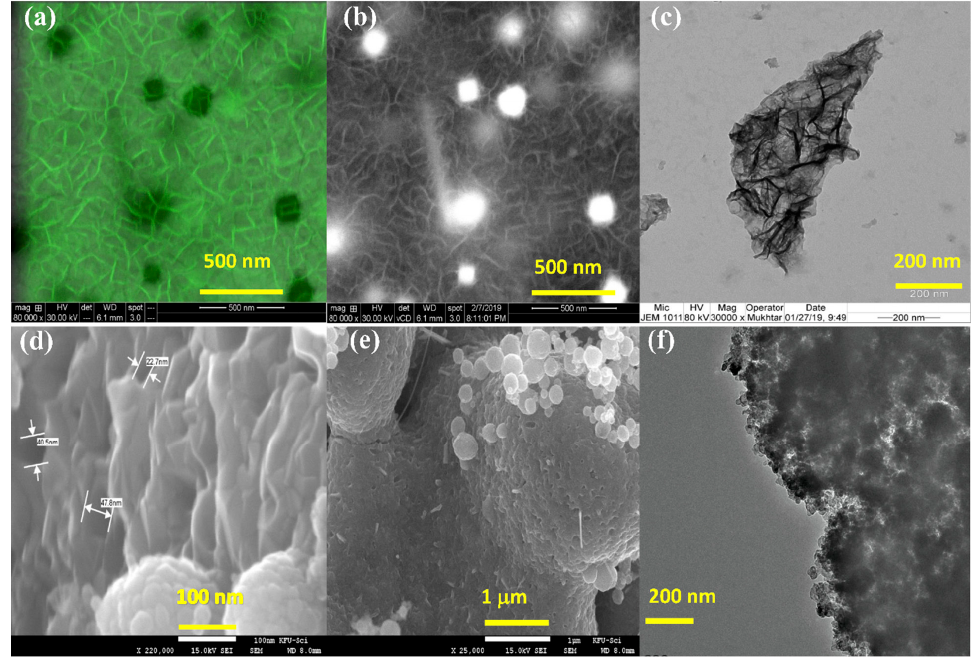
Figure 2. ( a ) High-magnification SEM image of HPC-Co (1), ( b ) SEM image of (1) using high-contrast detector, ( c ) TEM image of (1) and ( d – e ) SEM images of HPC-CoO (2) at different magnifications and ( f ) TEM image of (2).